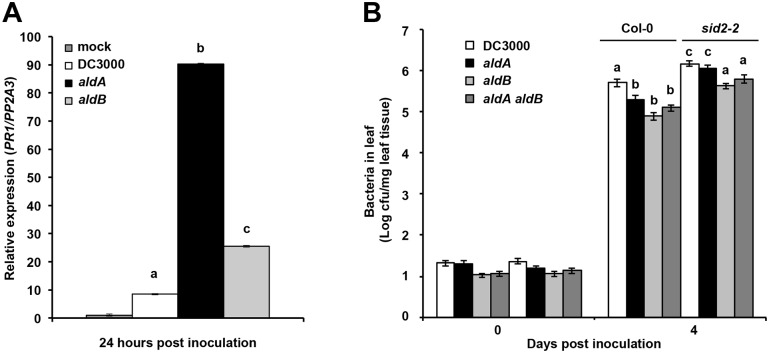
PR1 expression in plants inoculated by ald mutants and growth of ald mutants on SA-deficient sid2-2 plants.A) PR1 expression in Col-0 plants at 24 hrs following syringe infiltration (OD600 = 1x10-5). Significant elevation of PR1 expression in aldA-infected plants was observed in three independent experiments, and in two experiments for aldB-infected plants. B) Growth of ald single and double mutants on wild type A. thaliana (Col-0) and sid2-2 mutant plants following syringe infiltration. Graph shows composite data from 4 independent experiments. Letters indicate significant difference between samples within a given time point (p<0.02).